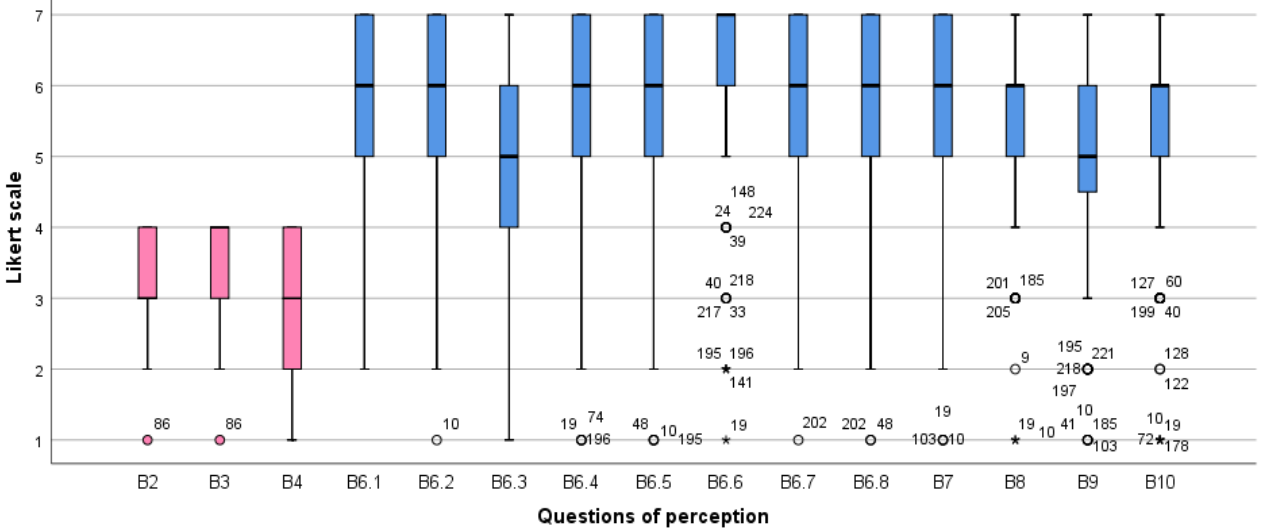
Figure 2. Box plot of perception of hand hygiene among nursing students (B2~B4, 4-point Likert scale (1–4); the others, 7 -point Likert scale (1–7)).